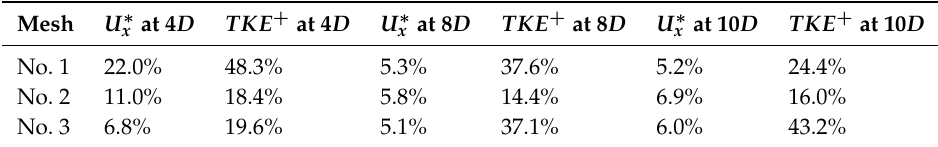
Figure 12. Contour of average TKE normalized by the upstream velocity U H /2 , 6.0 D downstream of the turbine: experimental data from [27] on the left and from the ALM-LBM simulation with Mesh No. 2 on the right. Average velocity vectors are projected onto the plane. Turbine footprint is delimited in black. Table 3. Root-mean-square of the error on the U ∗ x and TKE + z profiles. Error is averaged between z / D = 0.316 and z / D =